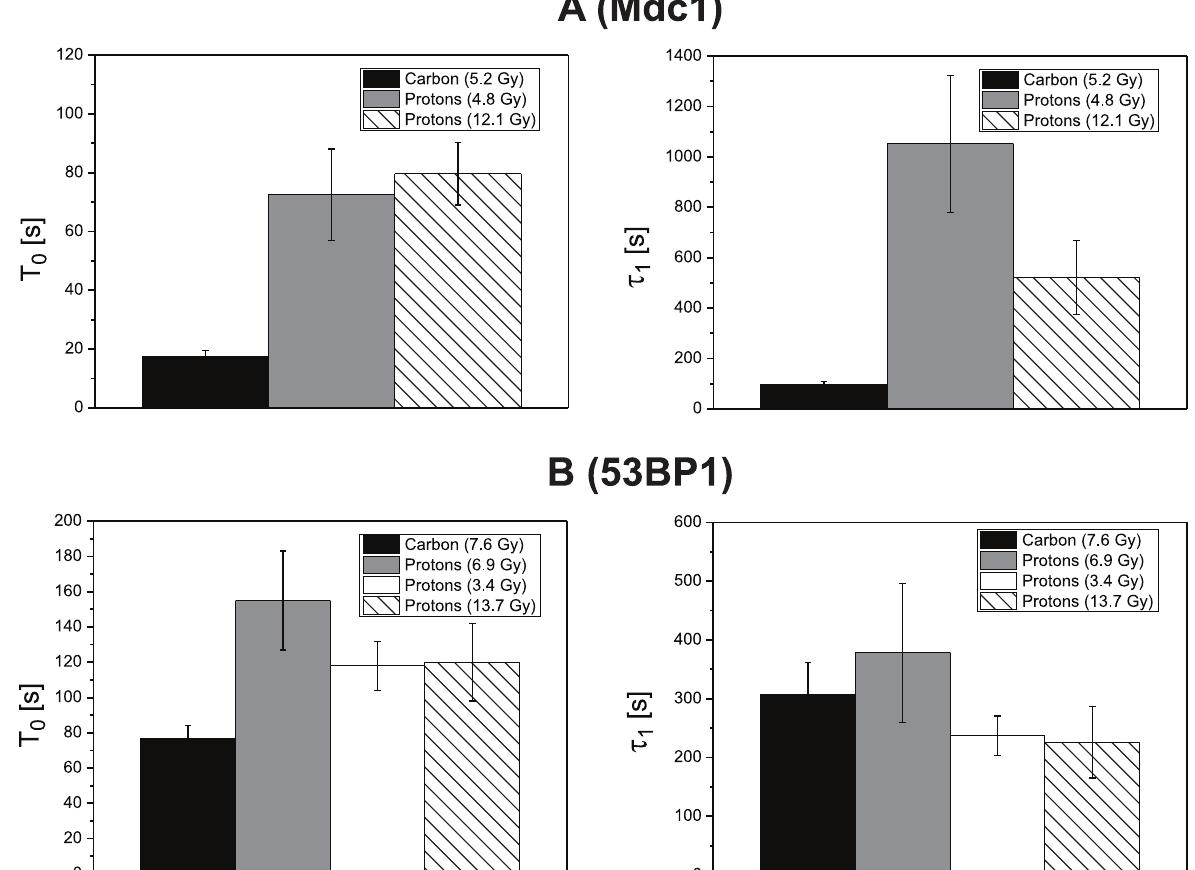
Figure 3. LET and dose dependence of recruitment kinetics. Weighted mean values and standard errors of the means of the kinetics parameters T 0 and t 1 of the proteins Mdc1 (A) and 53BP1 (B) after irradiation with 43 MeV carbon ions and two or three different doses of 20 MeV